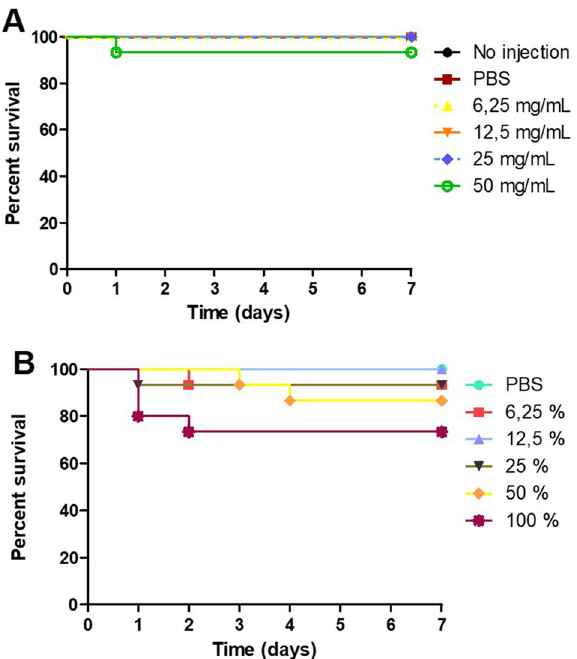
Figure 1. Galleria mellonella survival curve after inoculation of Rosmarinus officinalis glycolic extract and nystatin in different concentrations. ( A ) To compare the biocompatibility of different concentrations of the Rosmarinus officinalis glycolic extract with the control group (PBS). ( B ) To compare the biocompatibility of different concentrations of the nystatin with the control group